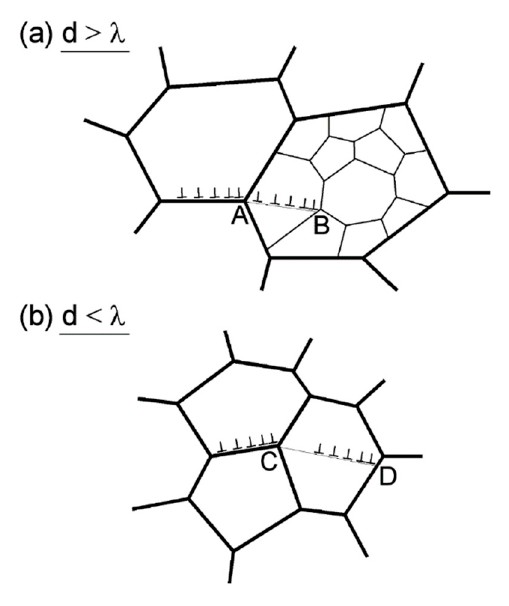
Figure 5. The mechanism of grain boundary sliding ( a ) in conventional creep when d > λ and ( b ) in superplasticity when d < λ [27].